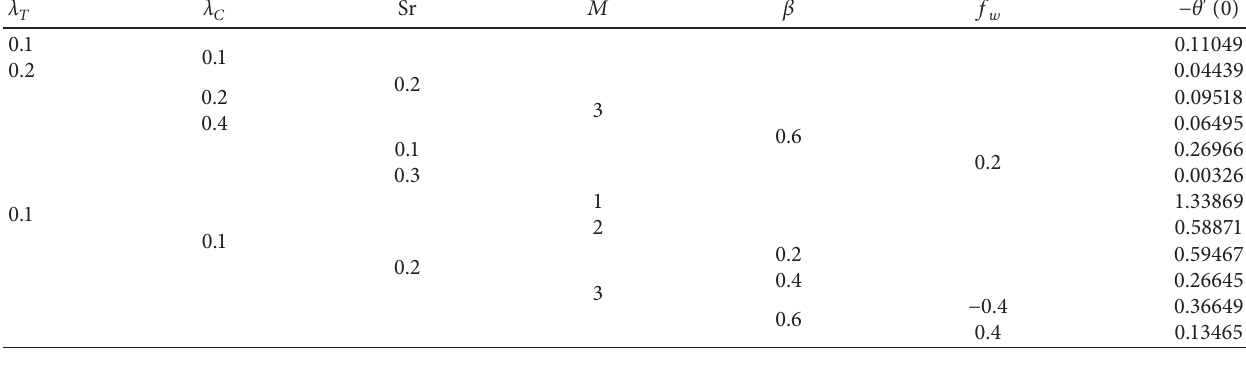
, λ , β , f , and M when Nt � Nb � 0 . 5 , Pr � 7 ,n � 1 , Ec � 0 . 5. T C w